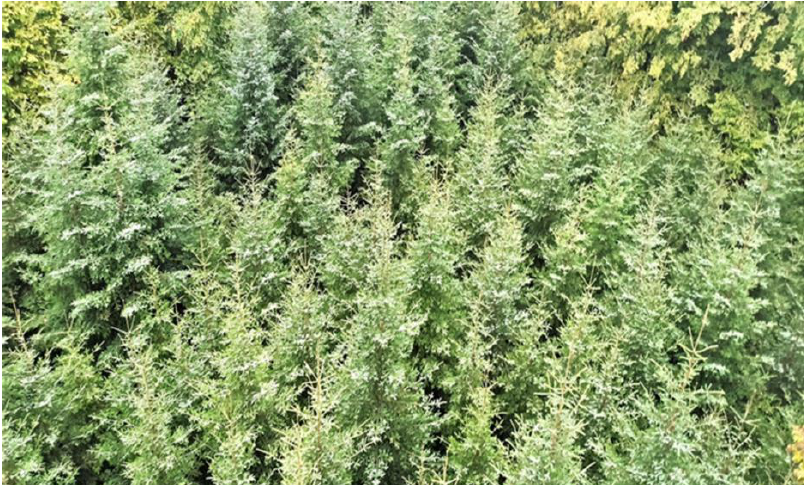
Figure 2. General view of plot No. 1 of the half-sib silver fir plantation from the lift when collecting cones in 2021 (photo by K. Wilamowski).